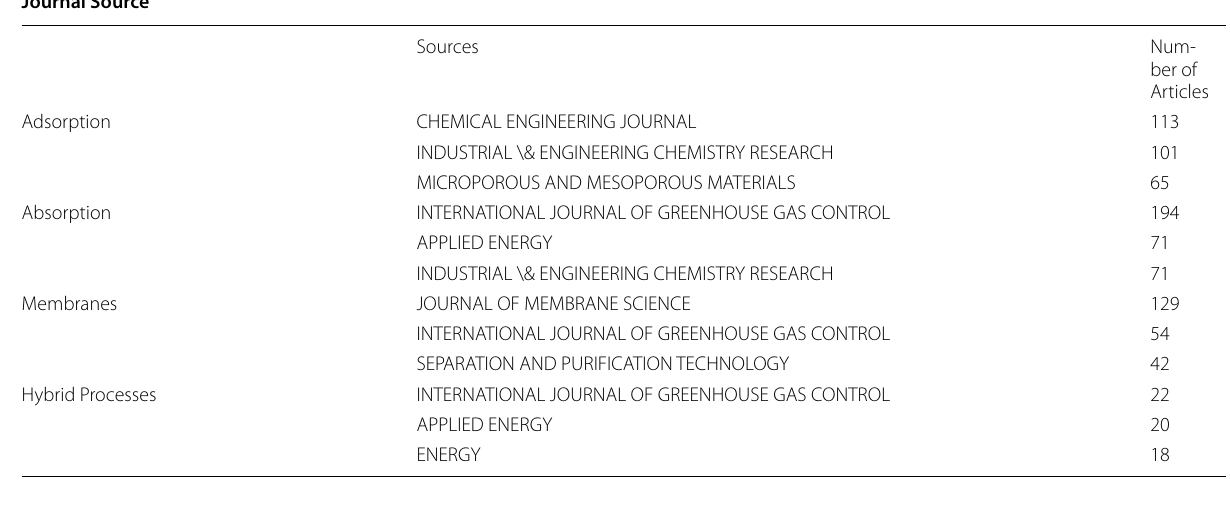
Table 3 Top three journal sources for each category